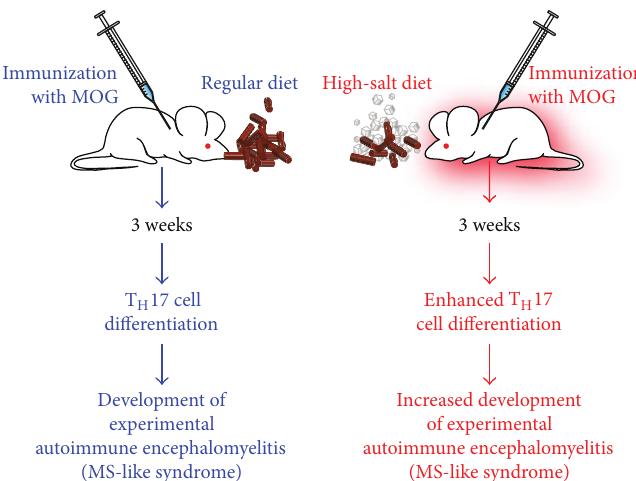
Figure 12: High-salt diet increases risk of autoimmune disease. In two groups of mice, both of which were immunized with MOG to induce EAE, the mice that had been given a high-salt diet (HSD) showed enhanced differentiation of na¨ıve T cells into pathogenic T H 17 cells and a subsequent increased, more profligate development of